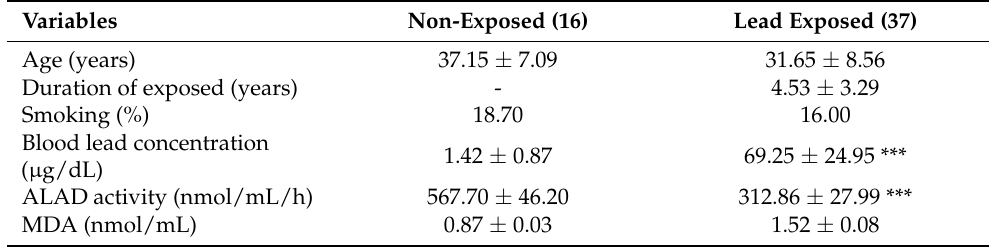
Table 1. Main characteristics of lead exposed and non-exposed workers (mean ± SD).